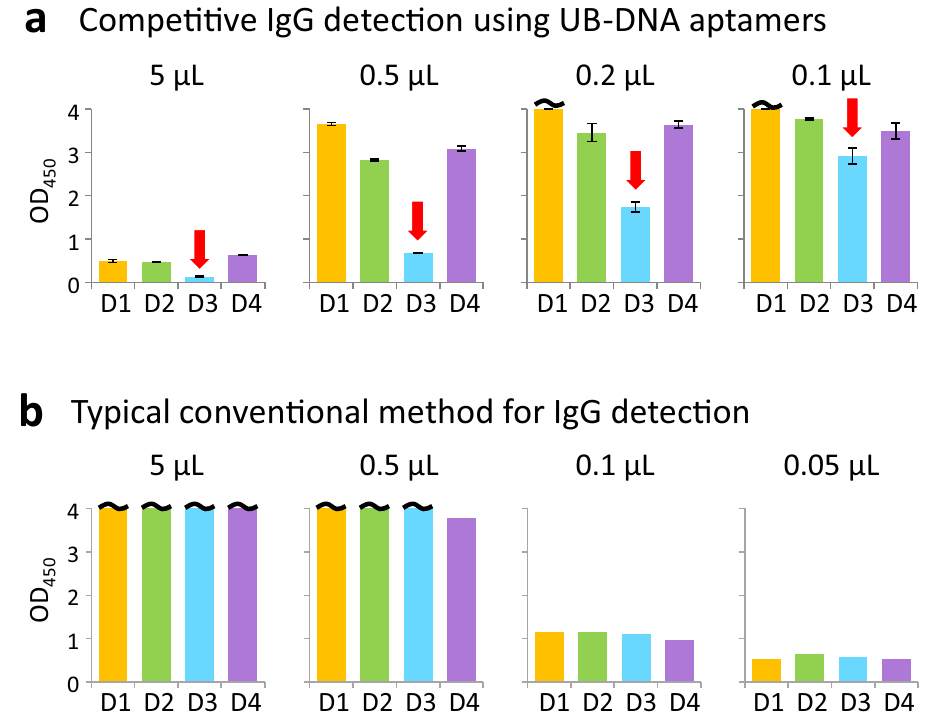
Figure 5. Comparison of the serotype-specific IgG detection by the competitive and conventional ELISA formats using a clinical sample (plasma, PD2-4). (a) The competitive Apt/Ab ELISA format (Fig. 1c), displaying the inhibition of the aptamer–DEN-NS1 binding by IgGs in our competitive Apt/Ab ELISA format using 0.1 to 5 µL of a clinical sample obtained within 4 days after fever onset. The amounts of the recombinant DEN-NS1 (The Native Antigen Company) added to each well (50 μL) were 350 pg for DEN1-NS1, 350 pg for DEN2-NS1, 450 pg for DEN3-NS1, and 200 pg for DEN4-NS1. Red arrows indicate the higher inhibition of the